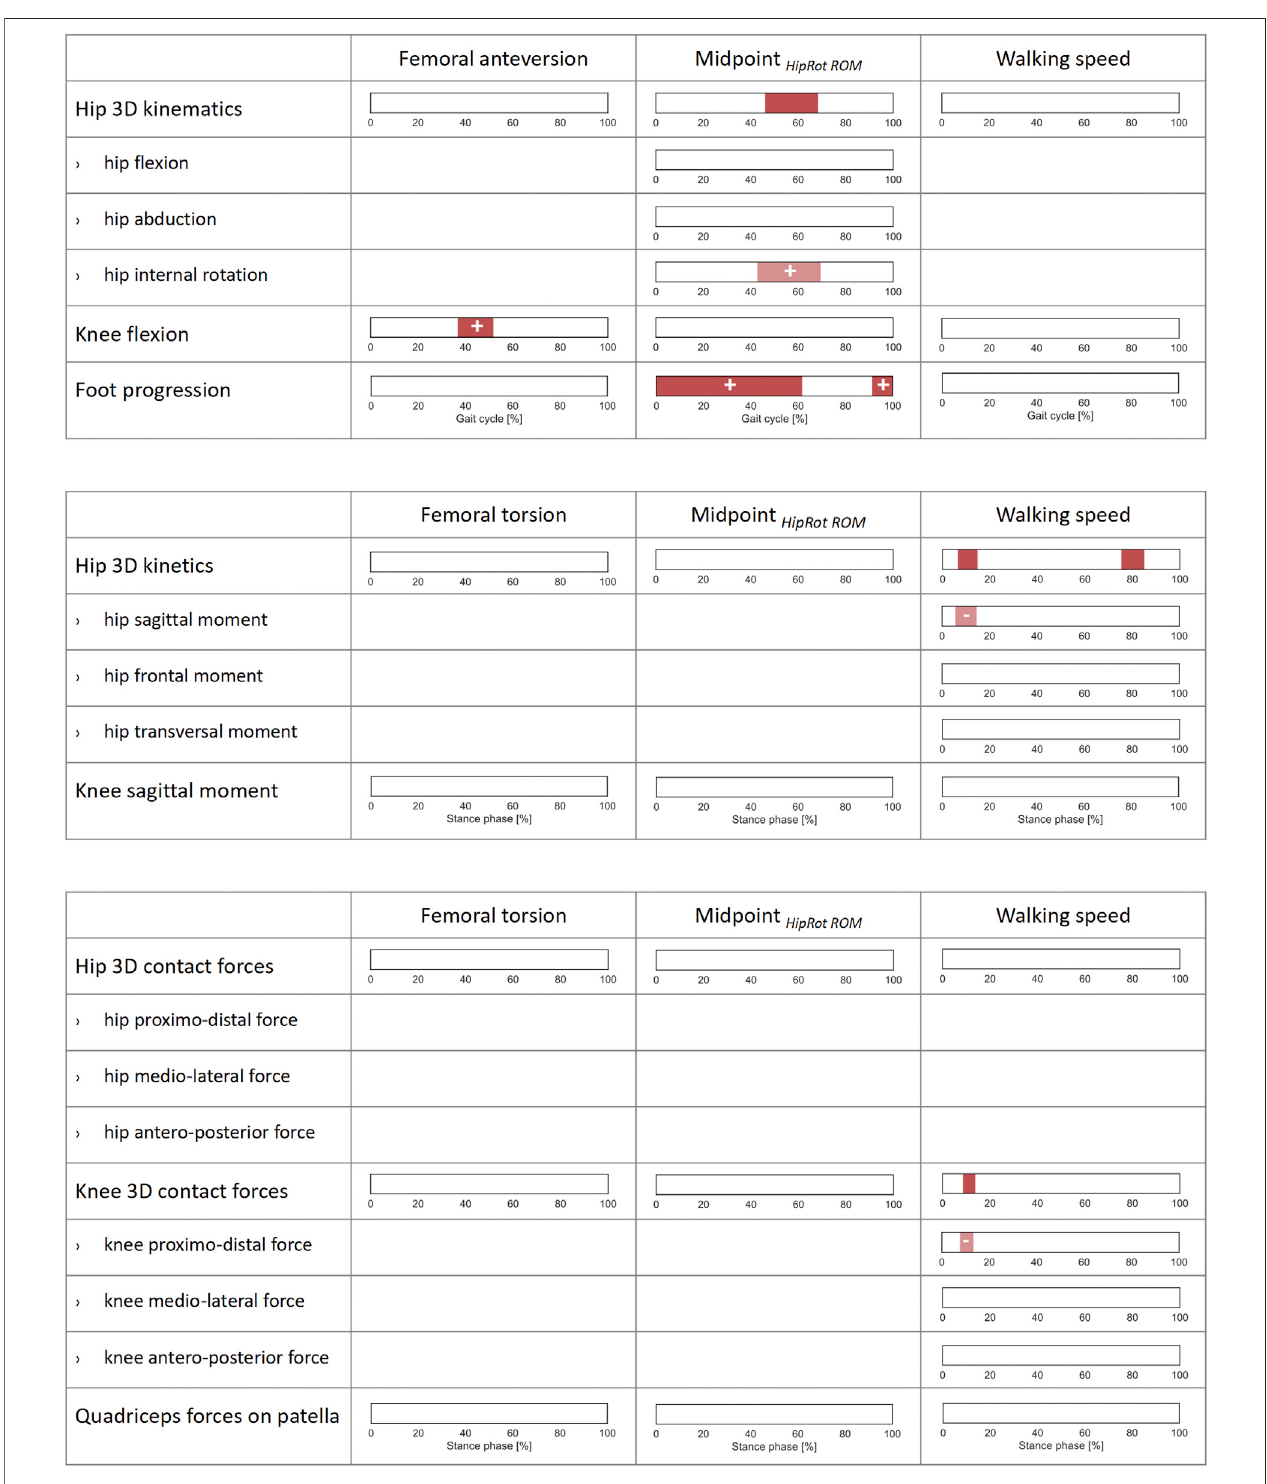
FIGURE 4 | Correlations of lower-limb kinematics, joint moments, and joint forces with femoral anteversion, midpoint of hip rotational range of motion (Midpoint ’ cohort. SPM canonical correlation analyses (CCAs) or scalar linear regressions were used to identify potential HipRot ROM ), and walking speed across the patients correlations of the 3D vector fi elds and 1D scalar outcome variables (rows) with the independent predictors (columns). Intervals of the gait cycle for kinematics and intervals of the stance phase for moments and forces which are characterized by a statistically signi fi cant correlation in the relevant SPM test are reported as red bars. Post-hoc scalar linearregressions wereconductedon theindividual componentsofthevector fi elds, for whichintervalswithsigni fi cantcorrelationsare reported in light red. The sign of the correlation is indicated on each interval for all scalar linear regressions. For a correct interpretation of the directionality of the correlation, the reader is referred to the axes reported in the corresponding graphs in Figures 1 , 2 .